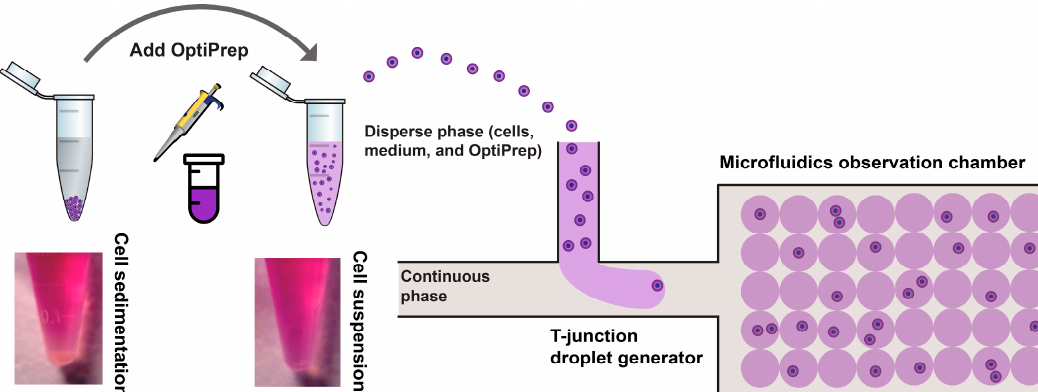
Figure 1. Schematic of a droplet-based microfluidic platform for highly efficient single-cell Figure1. Schematicofadroplet-basedmicrofluidicplatformforhighlye ffi cientsingle-cellencapsulation encapsulation using neutral buoyancy of suspension. Using an appropriate concentration of using neutral buoyancy of suspension. Using an appropriate concentration of OptiPrep ™ in culture OptiPrep™ in culture medium prevents cell sedimentation. medium prevents cell